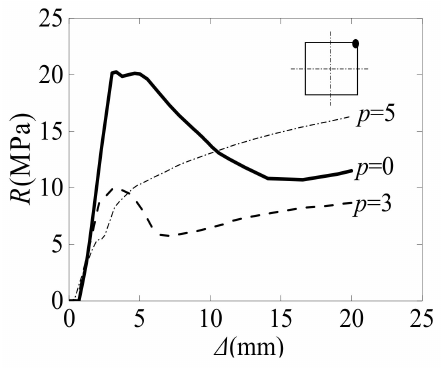
Figure 13. The relationship between the normal contact stress and axial